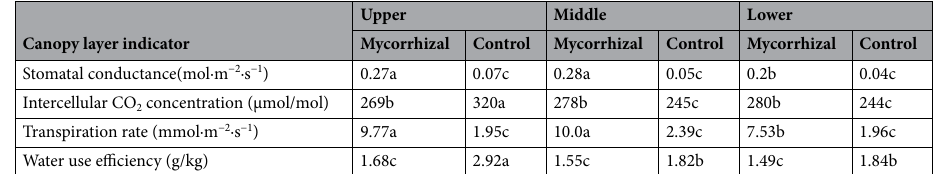
Canopy layer indicator